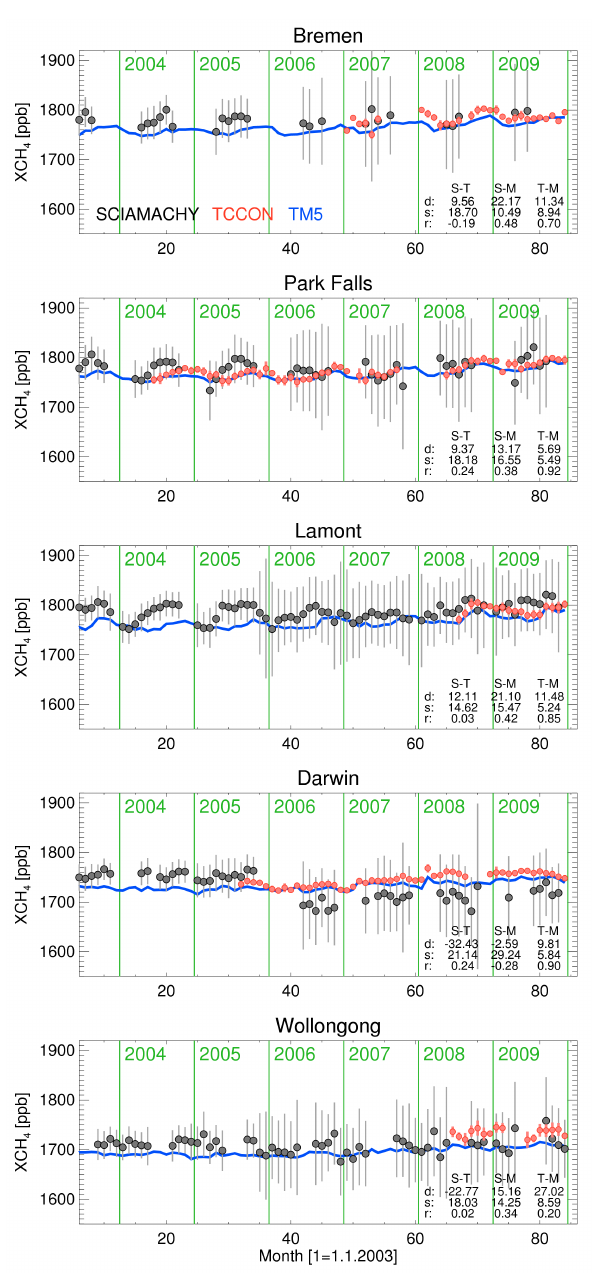
Fig. 3. Intercomparison of the SCIAMACHY WFMDv2.0.2 XCH 4 time series of monthly means with ground based Fourier Transform Spectroscopy (FTS) measurements and TM5-4DVAR at selected TCCON sites for the years 2003–2009 as in Fig. 1. The complete results are summarised in Table